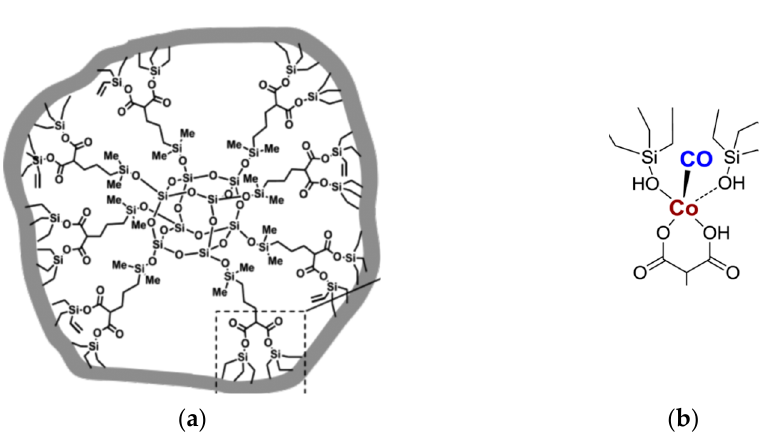
Figure 6. Stabilizing complex ( b ) with Co(I) oxidation state in a discrete nanocage ( a ) of core − shell design (Shen et al., 2014) [71].